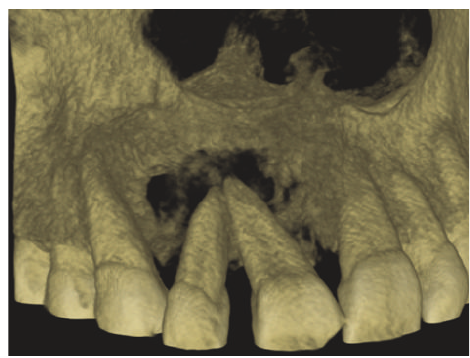
Figure 32: Reconstructed 3D CBCT